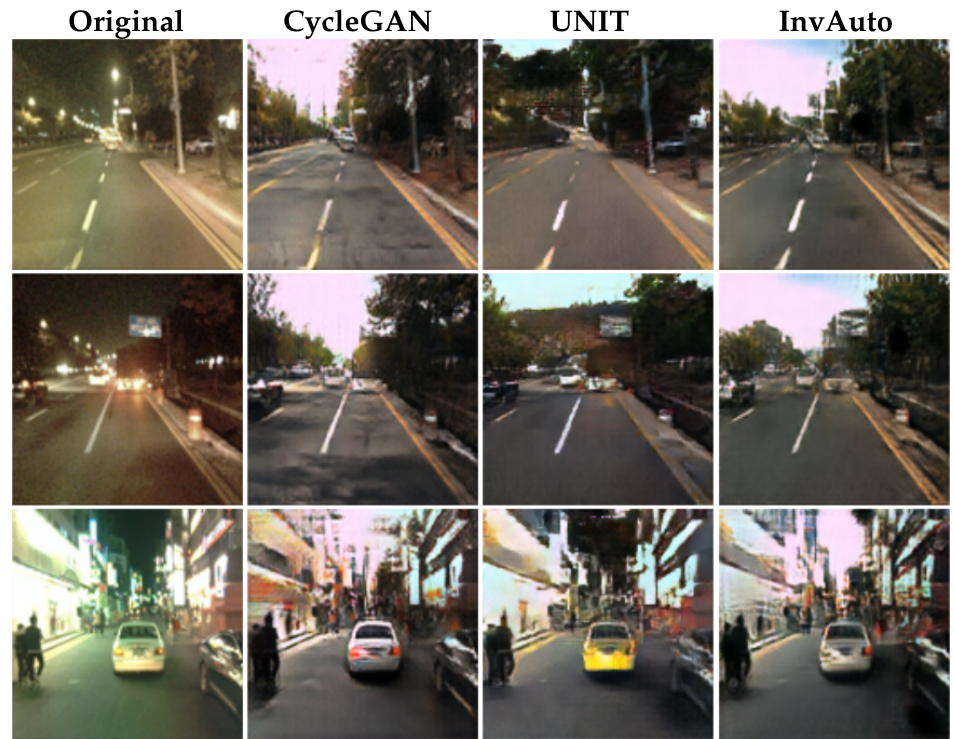
Figure A6. Night-to-day image